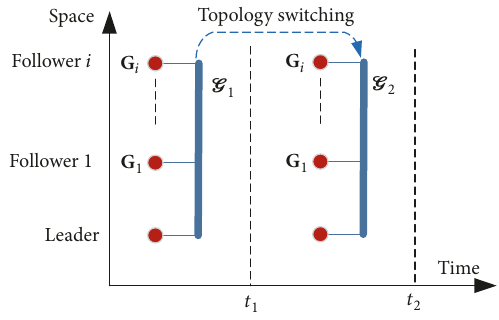
Figure 3: Spatial and time coupling of